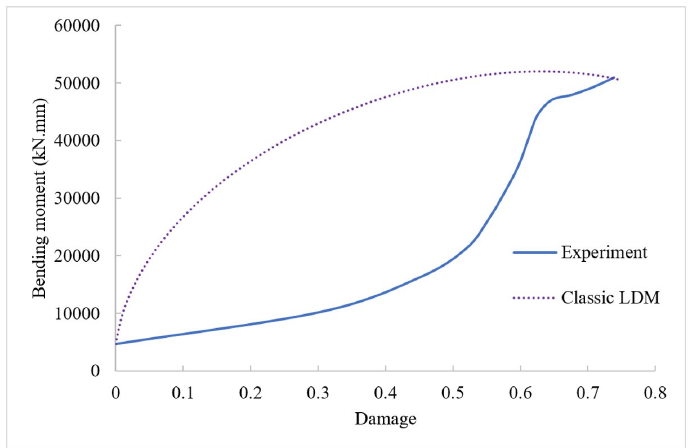
Figure 4. Experimental bending moment vs. damage results from Álvares [31] compared with the classic LDM